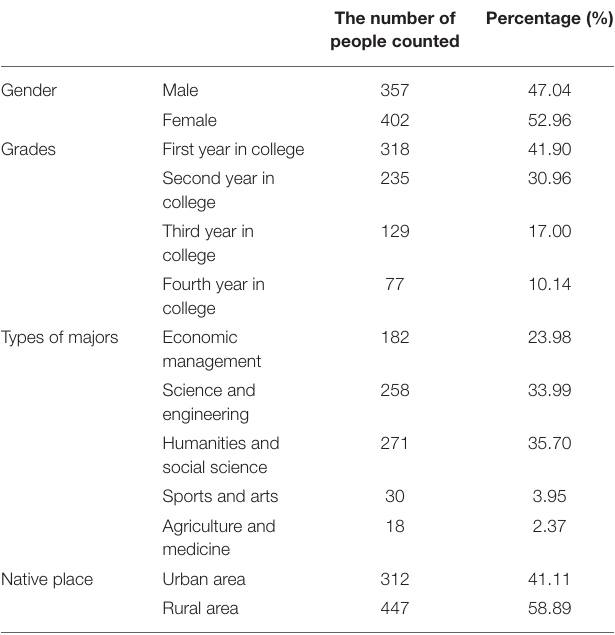
TABLE 1 | Analysis of survey subjects’